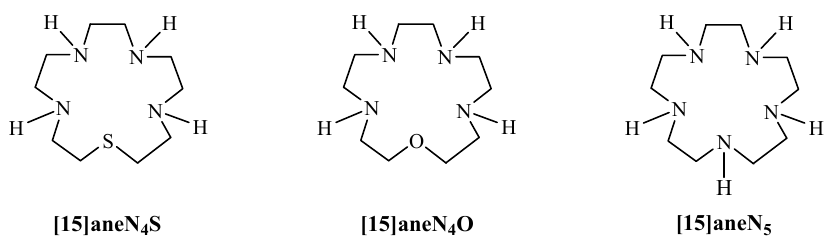
O and [15]aneN 4